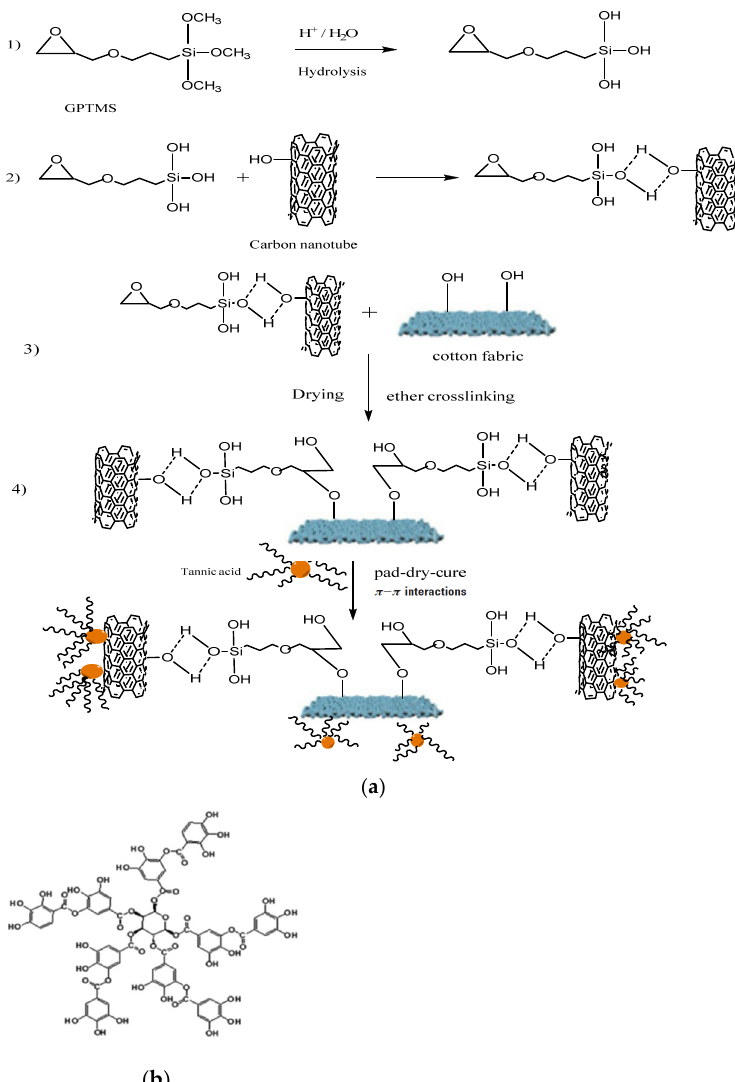
Figure 1. ( a ) Schematic mechanism for deposition of MWCNTS–GPTMS/tannic acid nanocomposite on the surface of cotton fabric; ( b ) Structure of tannic acid.